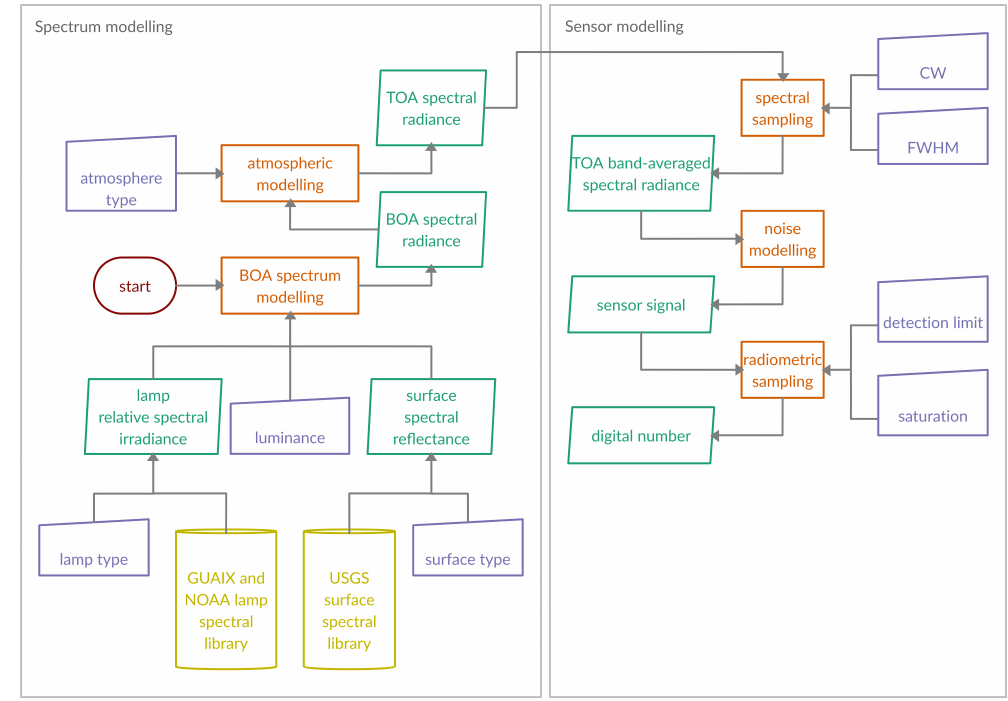
Figure 4. Framework for simulation of a spectral band’s sensor